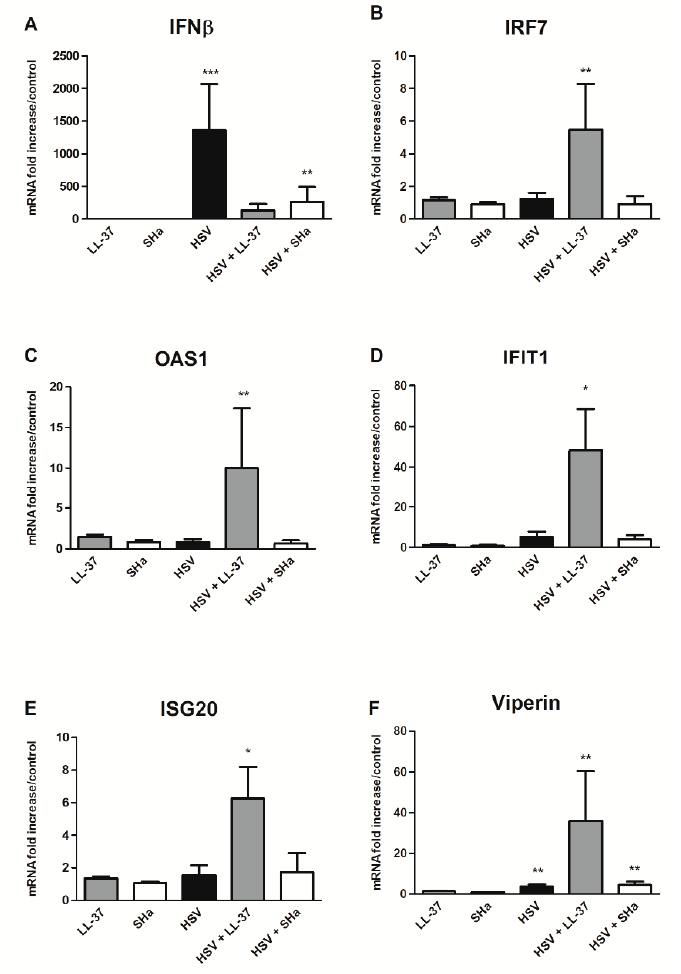
Figure 3. Modulation of the HSV-induced anti-viral response of human primary keratinocytes by LL-37 (2.5 µ M) and SHa (10 µ M). IFN β ( A ), IRF7 ( B ), OAS1 ( C ), IFIT1 ( D ), ISG20 ( E ) and viperin ( F ) mRNA expression was quantified in human primary keratinocytes incubated with AMPs alone and 24 h post-infection with HSV-1 at an MOI of 0.1 in presence or absence of AMPs. Data are represented as mean + SEM of at least three independent experiments. * p < 0.05, ** p < 0.01 and *** p < 0.01 compared with the uninfected control.